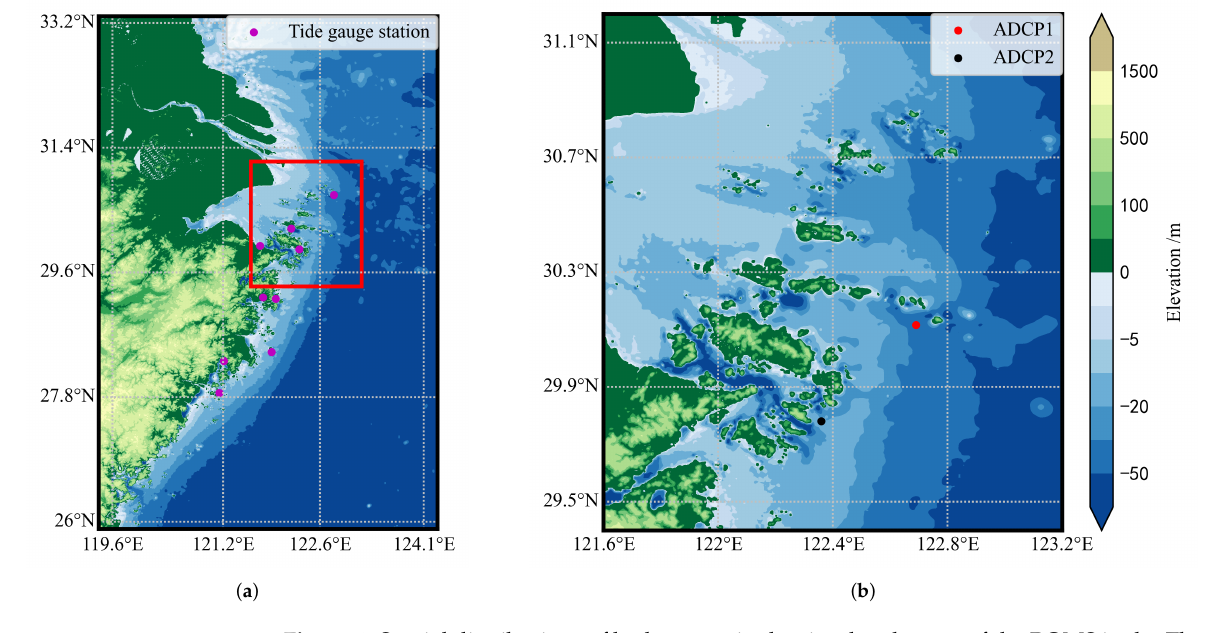
Figure 4. Spatial distributions of bathymetry in the simulated range of the ROMS in the Zhoushan sea. ( a ) The parent domain for the simulation. The pink dots indicate the locations of nine tidal gauge stations used for the model data validation. ( b ) The child domain for simulation, indicated by the red box in ( a ). The red dot indicates the placement of the observation equipment ADCP1 used for the corrected data validation in the subsequent experiment. The black dot indicates the location of ADCP2 used for model data validation.